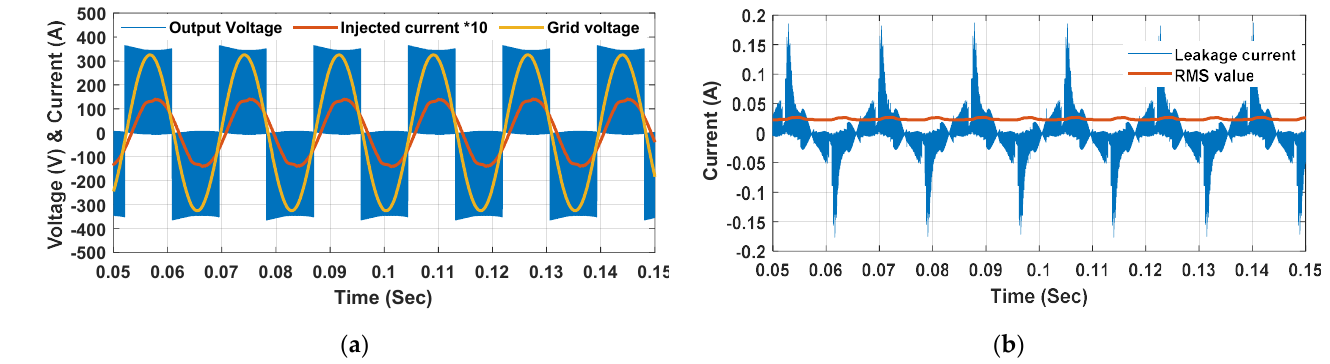
Figure 13. Normal operation of IFTPVI, ( a ) output voltage, injected current and grid voltage; and ( b ) leakage current.